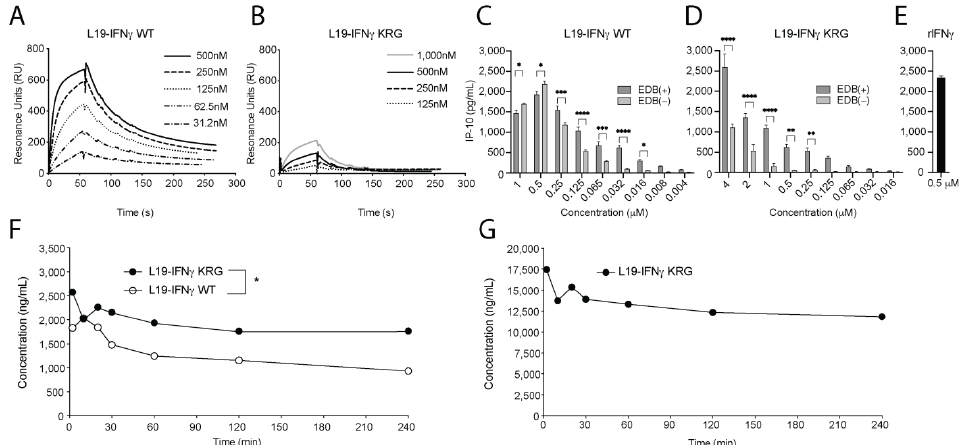
Figure 2. Fully human L19-IFN γ KRG functional characterization. ( A ) SPR of L19-IFN γ WT on human IFN γ R1. ( B ) SPR of L19-IFN γ KRG on human IFN γ R1. ( C ) IP-10 release on THB-1 cells exposed to titration of L19-IFN γ WT in coated EDB (+) and non-coated EDB ( − ) wells. ( D ) IP-10 release on THB-1 cells exposed to titration of L19-IFN γ KRG in coated EDB (+) and non-coated EDB ( − ) wells. ( E ) IP-10 release on THB-1 cells exposed to recombinant IFN γ . ( F ) Pharmacokinetic analysis conducted in cynomolgus monkeys injected at the dose of 0.1 mg/kg of L19-IFN γ KRG and L19-IFN γ WT. ( G ) Pharmacokinetic analysis conducted in cynomolgus monkeys injected at the dose of 0.5 mg/kg of L19-IFN γ KRG. (*: p < 0.05, **: p < 0.01, ***: p < 0.001, ****: p <